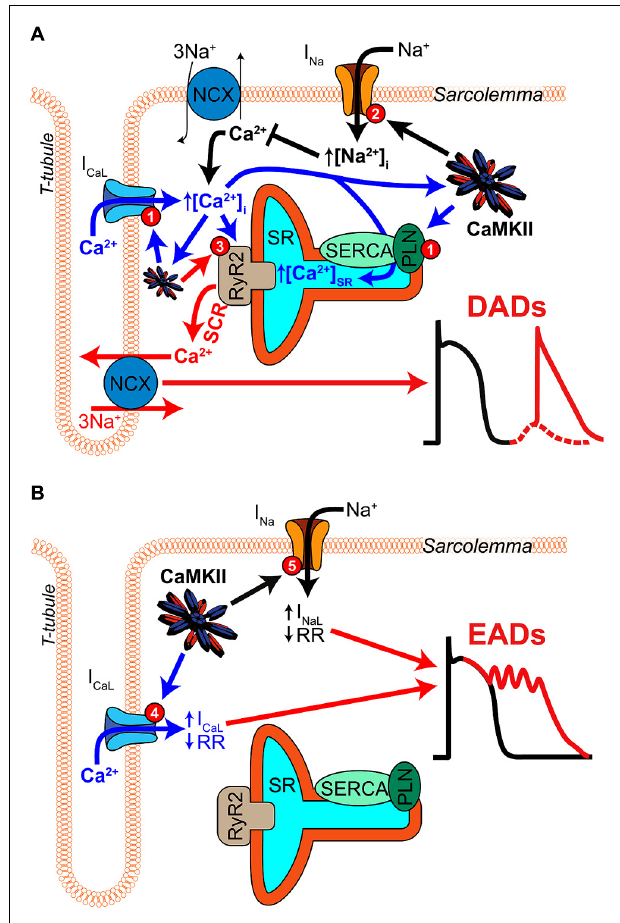
FIGURE 3 | Mechanisms of CaMKII-mediated afterdepolarizations. (A) Pathological CaMKII regulation can trigger diastolic SR Ca 2 + release resulting in electrogenic Ca 2 + extrusion by NCX and DADs (red arrows). This results from pro-arrhythmic CaMKII regulation at multiple target proteins, which together drive 3 mechanisms through which CaMKII promotes SCR. First, CaMKII elicits gain-of-function effects at I CaL and SERCA (via PLN-mediated disinhibition), thereby increasing Ca 2 + influx and resulting in Ca 2 + overload (mechanism 1, blue arrows). Second, CaMKII hyper-phosphorylation of Na V 1.5 can elevate intracellular Na + resulting in Na + -induced Ca 2 + -overload by decreasing Ca 2 + efflux through NCX (mechanism 2, black arrows).Third, CaMKII directly phosphorylates RyR2, which has been shown to promote SCR and has been strongly implicated in a number of different models of arrhythmogenic disease (mechanism 3, red arrow). (B) CaMKII phosphorylation of depolarizing currents reduces repolarization reserve and promotes EADs (red arrows) in certain disease contexts. Altered LCC gating due to CaMKII hyper-activity can elicit EADs by increasing and prolonging I CaL (mechanism 4, blue arrows). Na V 1.5 phosphorylation increases I NaL and may lead to non-equilibrium reactivation of I Na (mechanism 5, black arrows), both of which can trigger